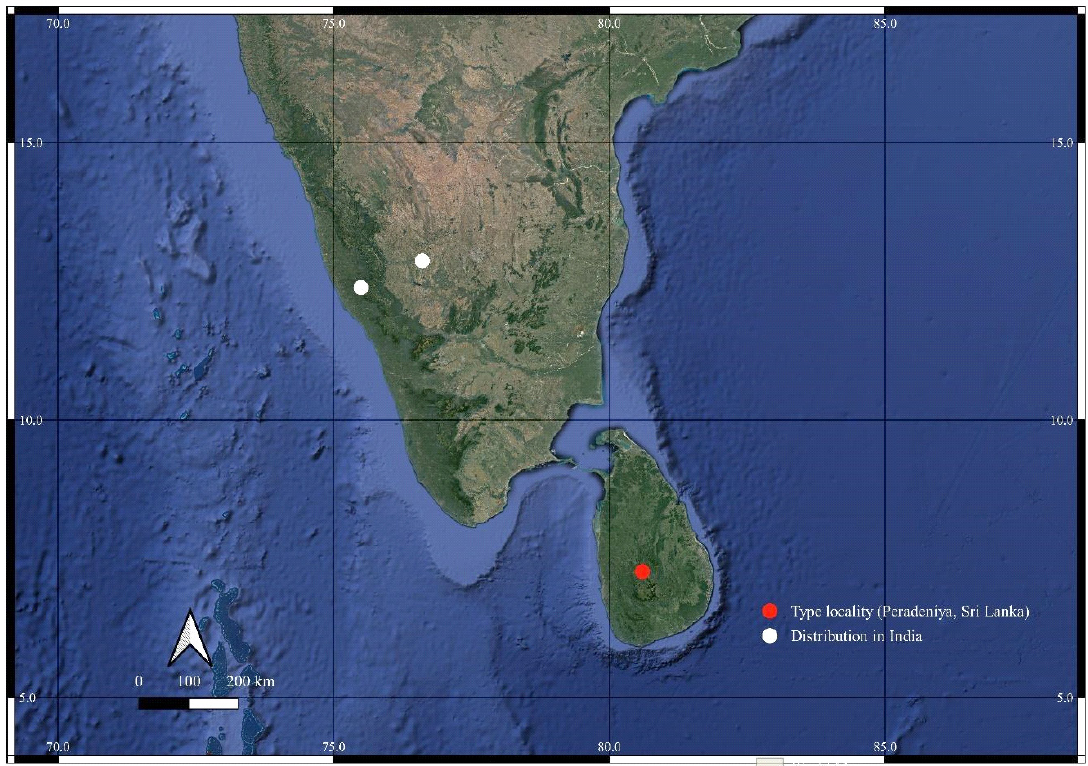
Fig 6 . Registries of Pericapritermes ceylonicus